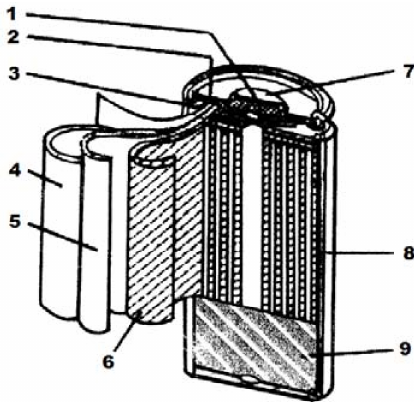
Figure 11. Schematic diagram of a low-cost battery design with 1: rubber, 2: vent cap, 3: plastic gasket, 4: positive electrode, 5: separator, 6: negative electrode, 7: positive terminal, 8: steel can, and 9: space filler